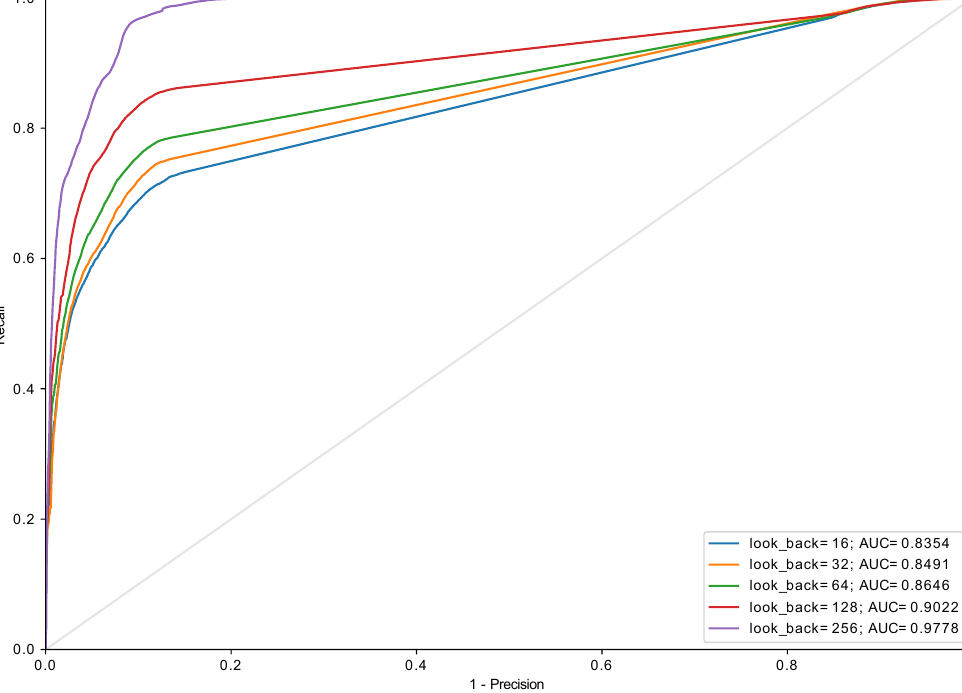
Figure 14. The ROC curve for algorithm recursive_adaptive ( in _ algorithm = recursive_adaptive , in _ grid = 32, GRU (two layers, 64 and 32 cells) +